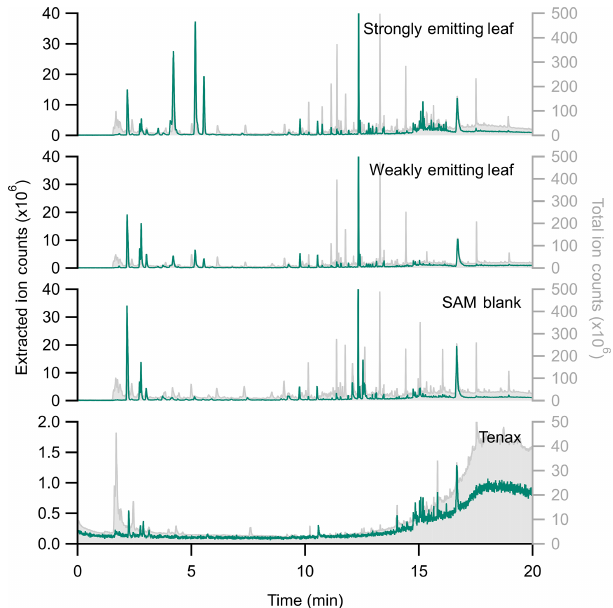
Figure 6. Stacked chromatograms comparing extracted ion chro- matograms (EIC using m/z 136, 135, 93, and 91; left, in green) with the total ion chromatogram (TIC, right, in grey) for a Tenax blank, a SAM blank, and a weakly and strongly emitting citrus leaf ( Citrus limon × Citrus medica ). Note the difference in axis scales between EIC and TIC. While several background peaks remain in the EIC, there are substantially fewer in the 10 + min range. The peak height of EIC isobornyl acrylate (RT = 12 . 3min) has been truncated. Note that retention times differ from Table 2; the column length had been shortened by the time of these measurements.